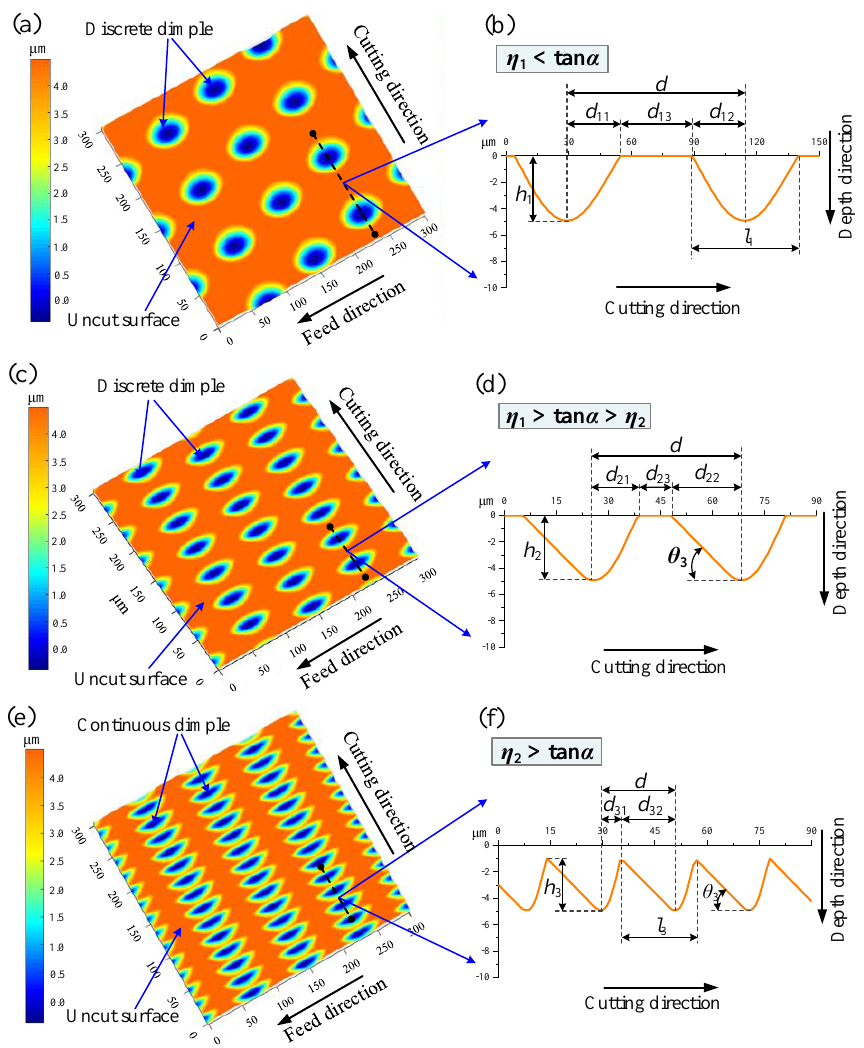
Figure 18. Simulated surface topographies and dimple profiles under processing parameters of f us = 19,670 Hz, A = 3.9 μm, R = 20 mm, DOC = 1 μm, f = 80 μm/rev, α = 15°, R c = 100 μm . ( a , b ) n = 800 r/min; ( c , d ) n = 400 r/min; ( e , f ) n = 200 r/min.